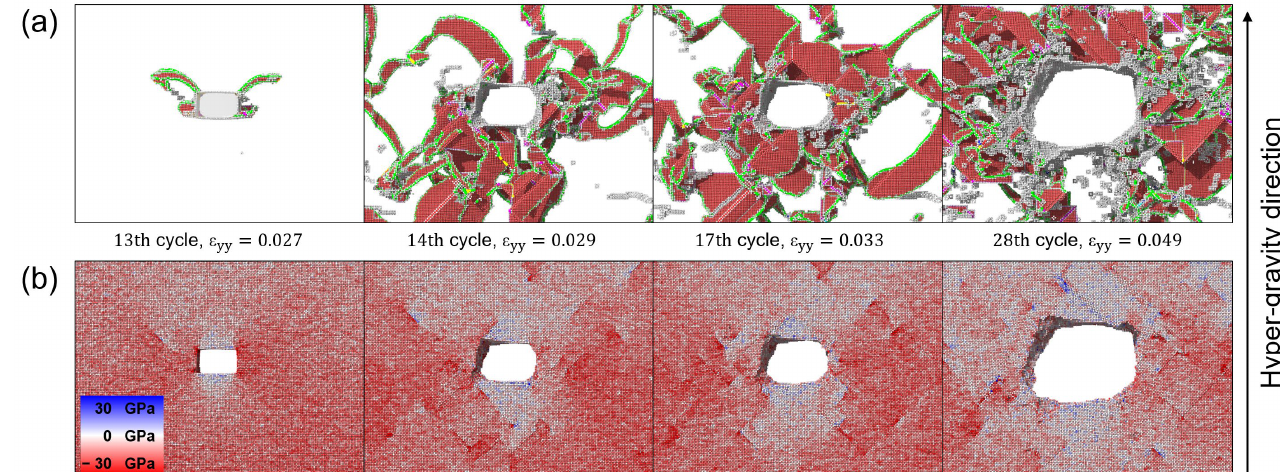
Figure 4. The microstructure evolution of [001](010) crack at 300 K and 3 × 10 12 g conditions. ( a ) The red and grey color indicate HCP and unidentified structures, respectively. FCC atoms have been deleted for the clarity of the picture. Dislocations are visualized by using the DXA algorithm. ( b ) atomic stress ( τ yy ) distribution at selected cycle